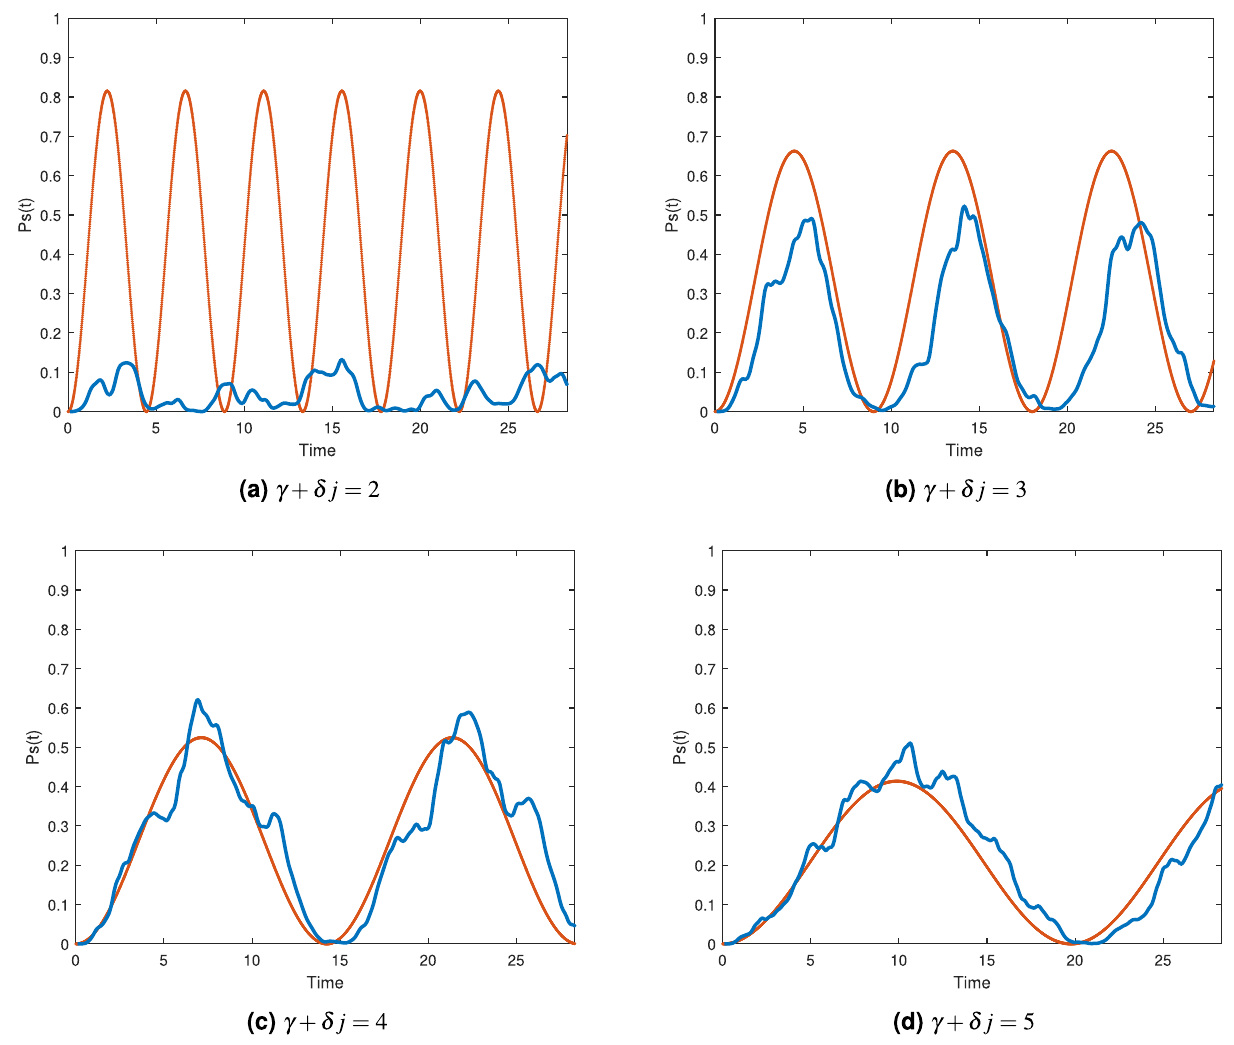
Figure 1. Comparison between simulations (blue line) and the analytical approximation (orange line) of P s ( t ) for initial state | 010001 � , d H = 3